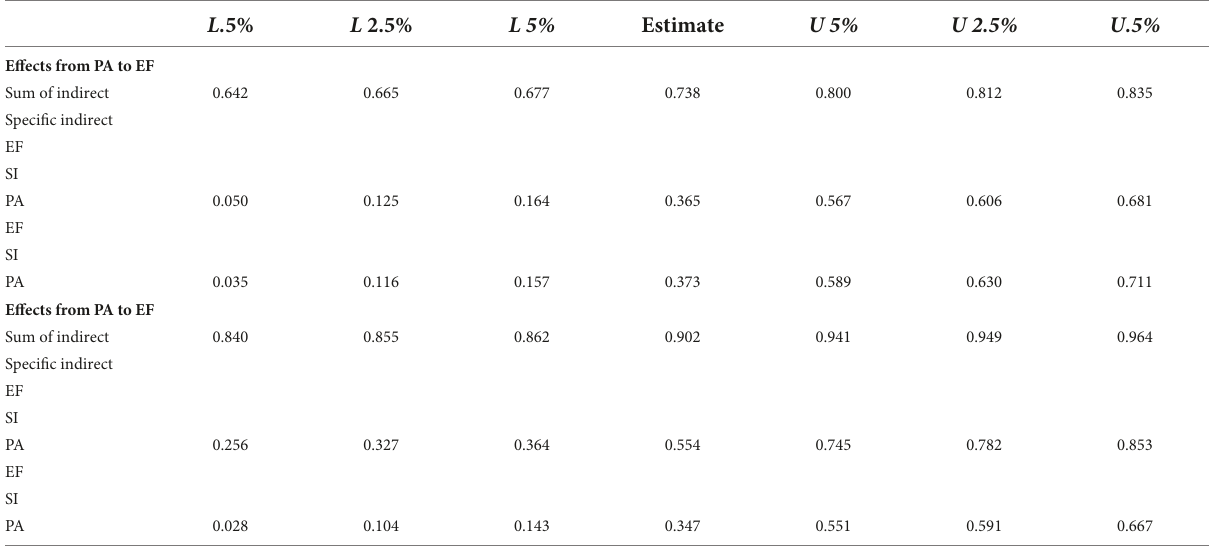
TABLE 2 Confidence intervals of standardized mediation effects. Confidence intervals of standardized total indirect effects, specific indirect effects, and direct